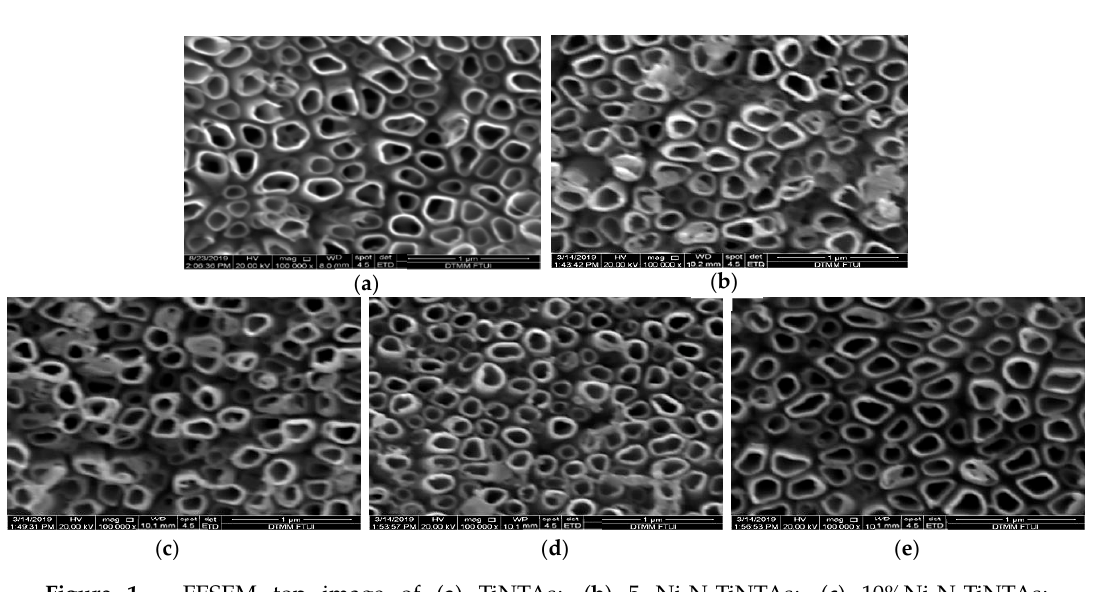
Figure 1. FESEM top image of ( a ) TiNTAs; ( b ) 5 Ni-N-TiNTAs; ( c ) 10%Ni-N-TiNTAs; ( d ) 15%Ni-N-TiNTAs and ( e ) 20%Ni-N-TiNTAs; with a magnification of 100 k.